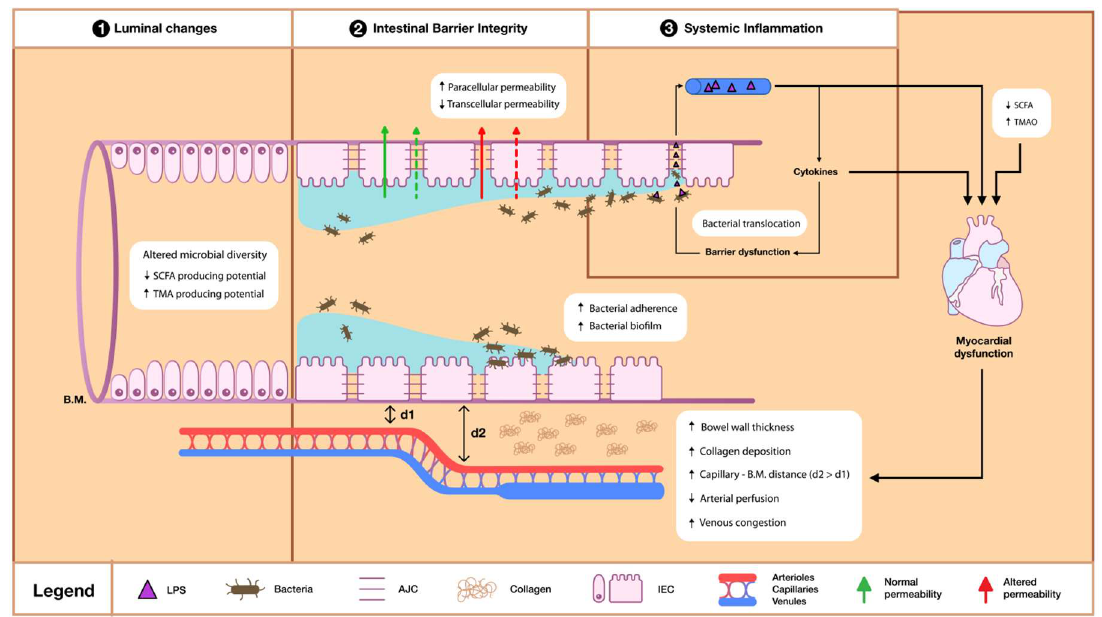
Figure 2. Simplified illustration of the gut-related causative pathways implicated in the pathophysiol- ogy of Heart Failure (HF). The underlying pathophysiological mechanisms can be roughly divided into 3 compartments. Within the colonic lumen, altered microbial diversity is characterized by an increase in Trimethylamine (TMA)-producing species and a concurrent reduction in Short-chain fatty acid (SCFA)-producing species, which collectively favor the preponderance of harmful metabolites. Regarding the second compartment, the proper functioning of intestinal enterocytes (IEC) is crucial for maintaining intestinal barrier integrity. IECs receive both luminal and capillary nutritional supply and are physiologically covered by a mucous layer, which restricts their contact with the colonic bacteria. Thus, under normal conditions, they can regulate proper transcellular absorption while at the same time they seal the paracellular pathway via the apical junctional complex (AJC). However, in HF, erosions of the mucous layer and overgrowth of adhesive pathogenic bacteria create the ideal environment for bacteria to impinge on IECs. Moreover, SCFA depletion, in combination with hemo- dynamic changes (hypoperfusion and congestion) and mechanical bowel wall derangements (collagen deposition), results in decreased trophic status of IECs. These changes disrupt the barrier and lead to an increase in paracellular permeability due to malfunctional AJCs, as well as a concomitant